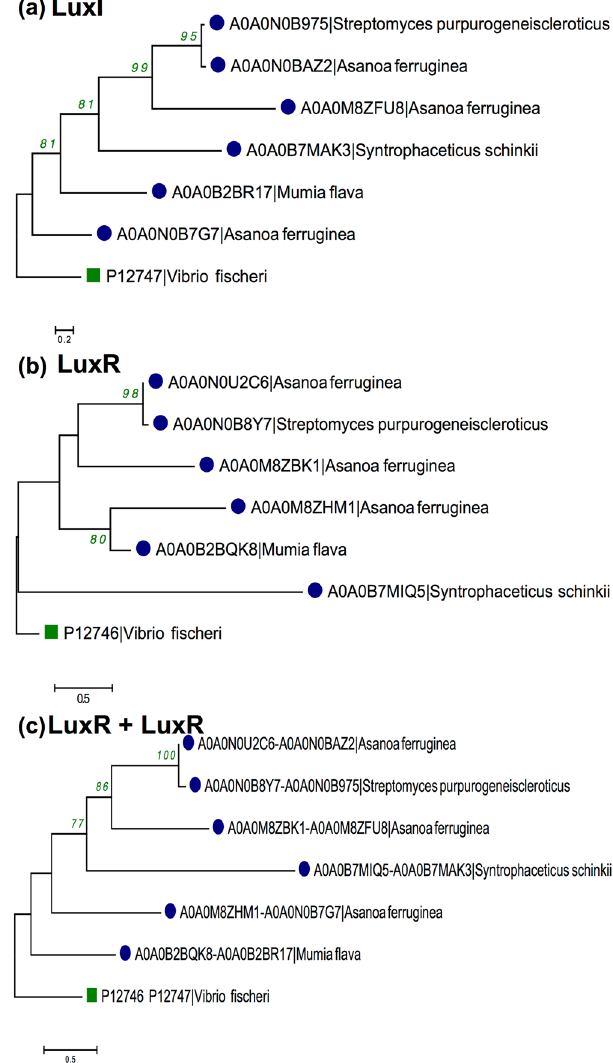
Figure 6. Phylogenetic tree reconstruction using Maximum Likelihood method for Gram-positive bacteria ( a ) LuxI containing sequences, ( b ) LuxR containing sequences, and ( c ) LuxR + LuxI sequences against V . fischeri LuxI and/or LuxR as outgroup. [ Gram-positive bacteria ( ), and Gram-negative bacteria (